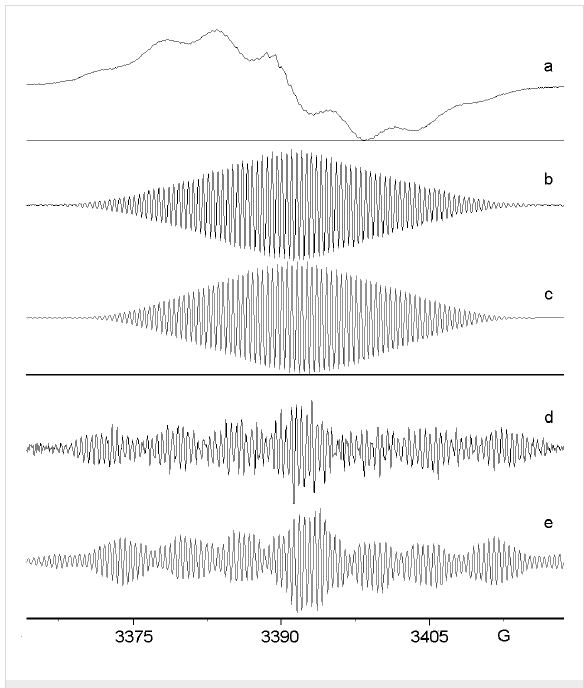
Figure 4: EPR spectra after GaCl 3 and InCl 3 reactions of azide 6 . (a) 1st derivative spectrum from 6 and GaCl 3 in DCM at 300 K. (b) 1st derivative spectrum of dimer ( 11c +• ) from 6 and HGaCl 2 in CH 3 CN at 300 K. (c) computer simulation of (b) with hfs of Table 1. (d) 1st deriva- tive spectrum of trimer ( 19 +• ) from 6 and InCl 3 in DCM at 300 K. (e) computer simulation of (d) with hfs of Table